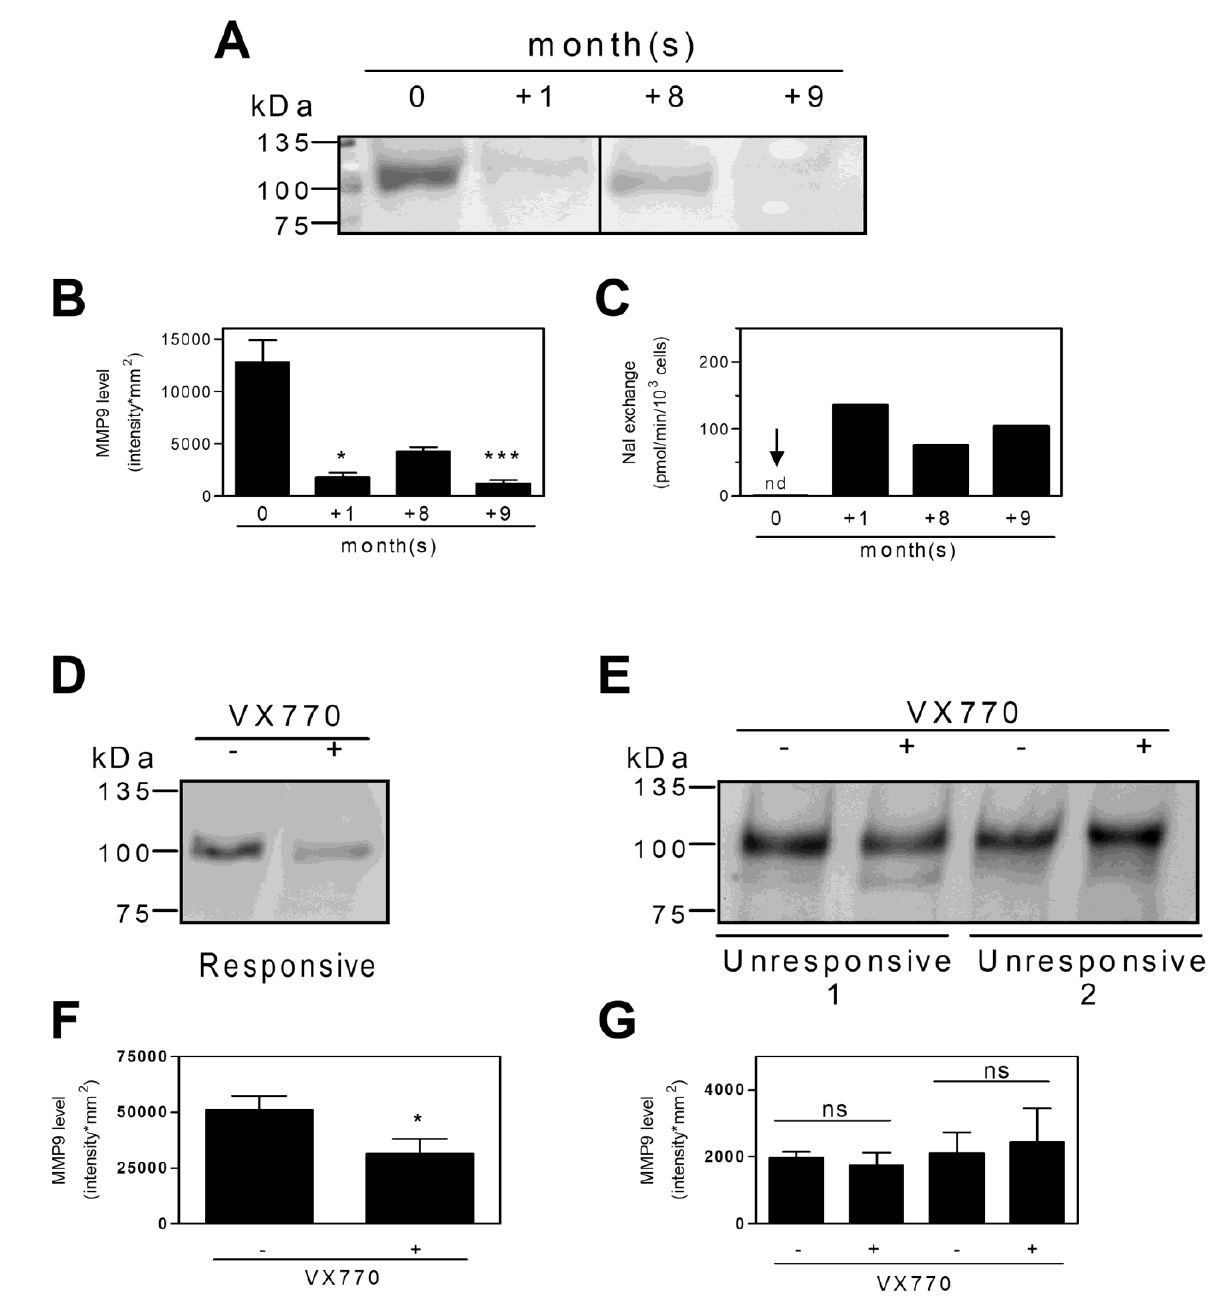
Figure 6. MMP9 levels in PBMCs following in vivo and ex vivo VX770 treatment: ( A ) PBMCs from CF patient carrying CFTR G1349D and F508del mutations were collected during the indicated months from the beginning of the Ivacaftor oral therapy. An aliquot of the cells was submitted to Western blot analysis for MMP9. MW protein markers (kDa) are reported. ( B ) The immunoreactive signals were quantified as specified in Methods and the data are the means ± SD from five quantifications. Statistical analysis was carried by means of a Kruskal–Wallis test followed by Dunn’s multiple comparison test. *** p < 0.001; * p < 0.05. ( C ) Selected CFTR activity values from those reported in Figure 2 for comparison to the MMP9 levels. ( D ) and ( E ) PBMCs from one responsive and two unresponsive CF patients to ex vivo VX770 treatment were submitted to Western blot for MMP9. MW protein markers (kDa) are reported. ( F ) The immunoreactive signals were quantified as specified in Methods and the data are the means ± SD from six quantifications. Statistical analysis was carried by means of Wilcoxon signed rank test. * p < 0.05. ( G ) The immunoreactive signals were quantified as specified in Methods and the data are the means ± SD from six quantifications. Statistical analysis was carried by means of Wilcoxon signed rank test. ns, not statistically